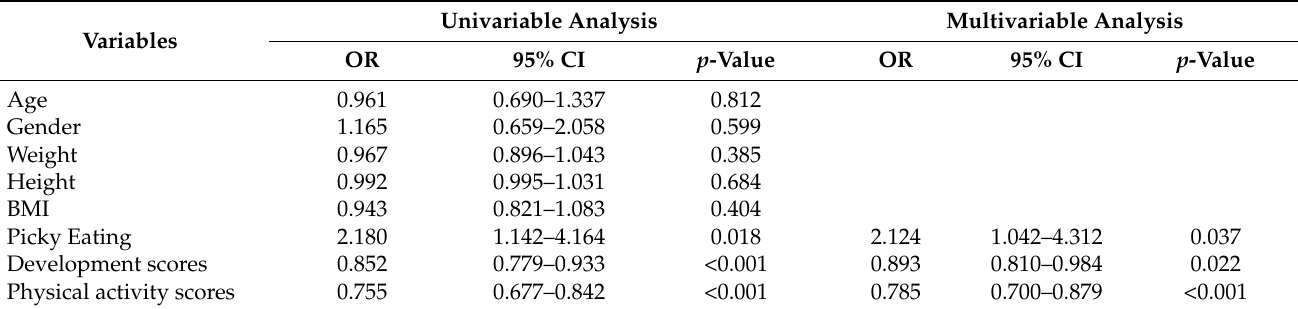
Table 8. Association of zinc deficiency with demographics and clinical factors.